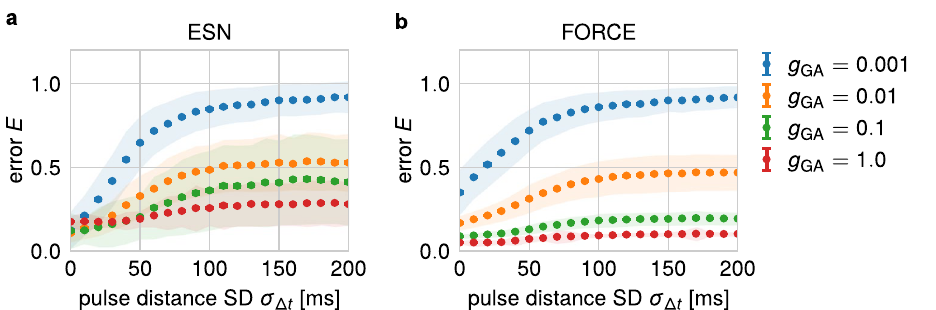
Figure 4. Influence of variances in input timings on the performance of the network with specially-trained neurons. The normalized readout error E of a network with specially-trained neurons decreases with larger values of the standard deviation g GA determining the feedback between specially-trained neurons and network. If this standard deviation equals 1, the error stays low and becomes basically independent from the standard deviation σ Δ t of the inter-pulse intervals of the input signal. ( a ) ESN approach; ( b )